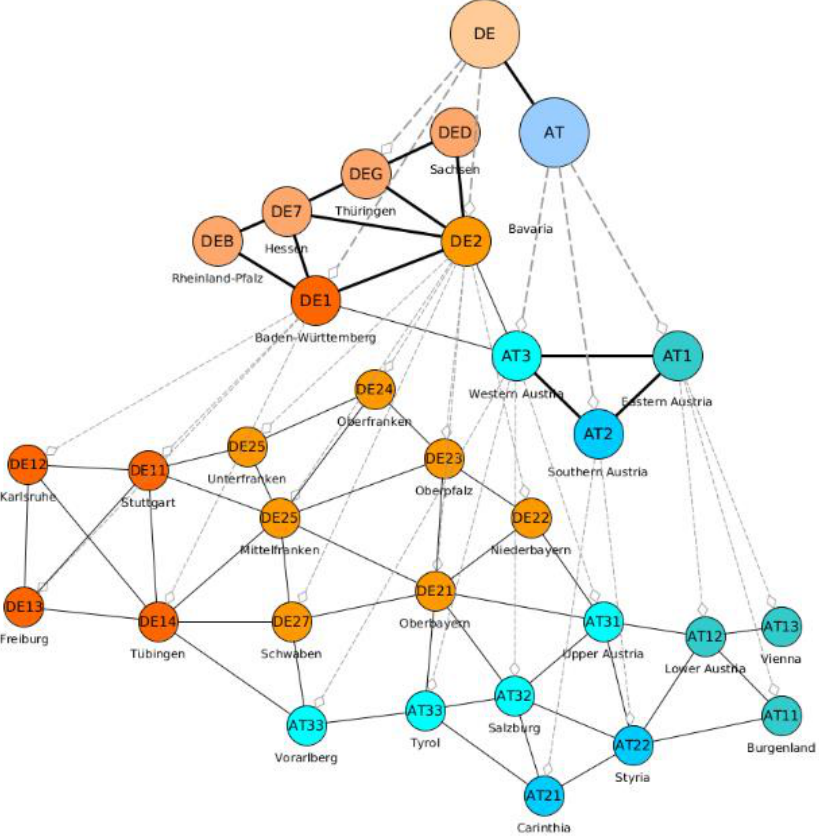
Figure 22. A visualisation of a connected and hierarchical graph of NUTS for some regions of southern Germany and Austria.